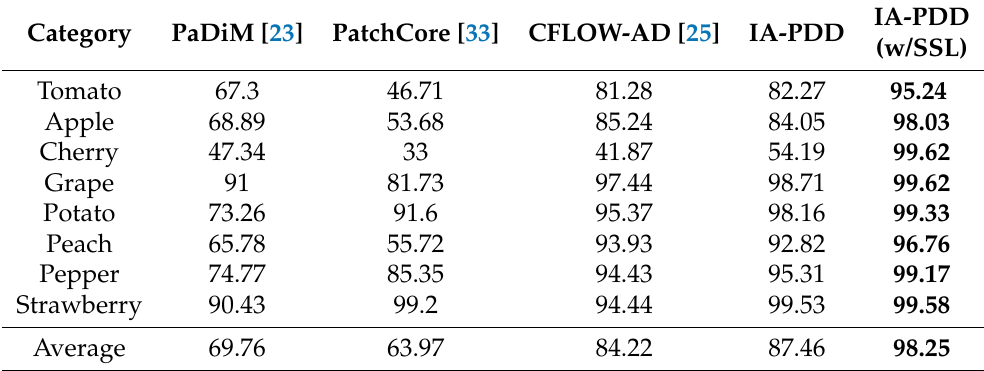
Table 2. Quantitative results for PlantVillage [14] dataset at image-level with respect to AUROC, where “w/SSL” means “with self-supervised pretraining of feature